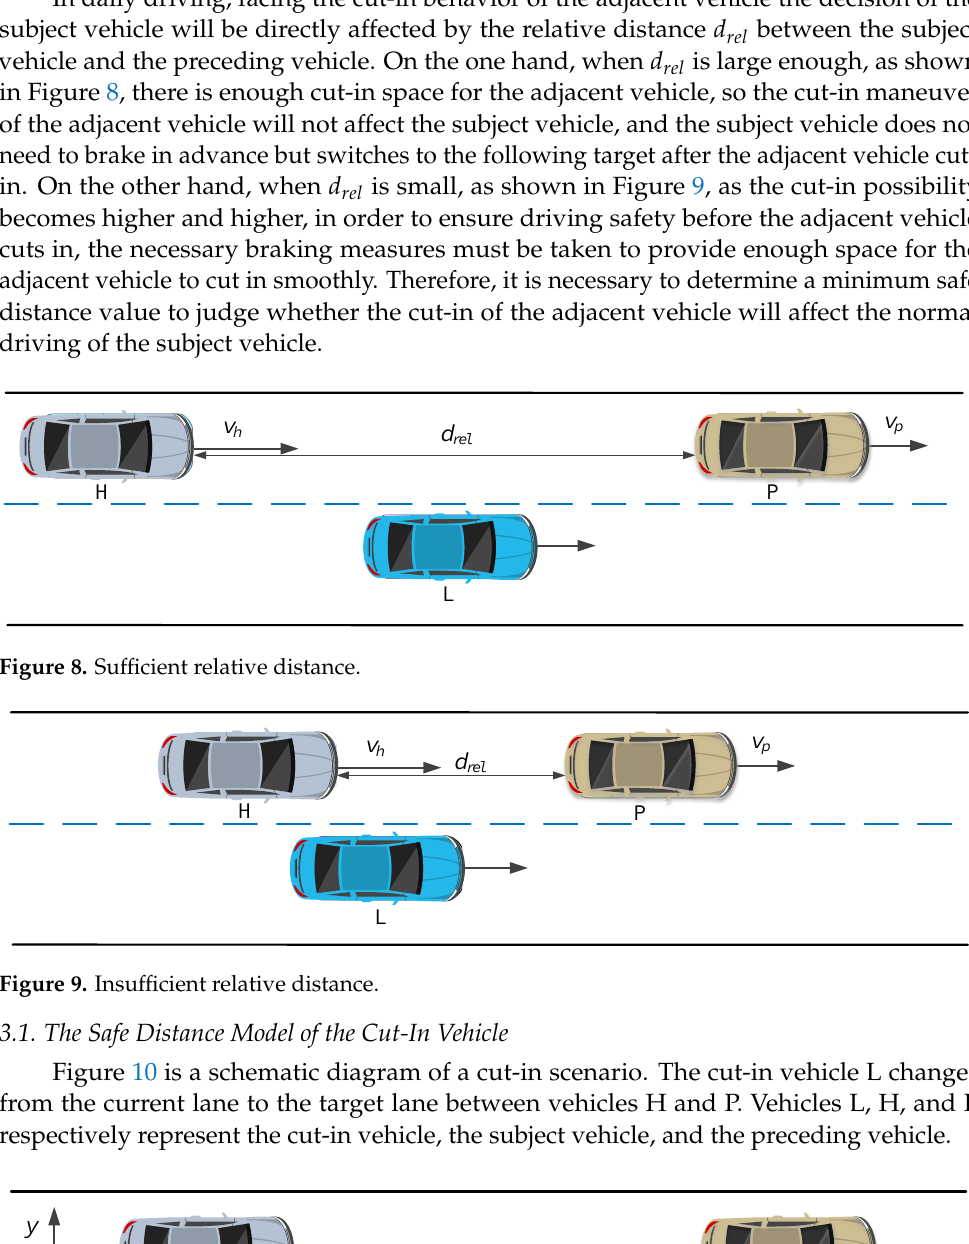
Figure 7. Driver preview model.